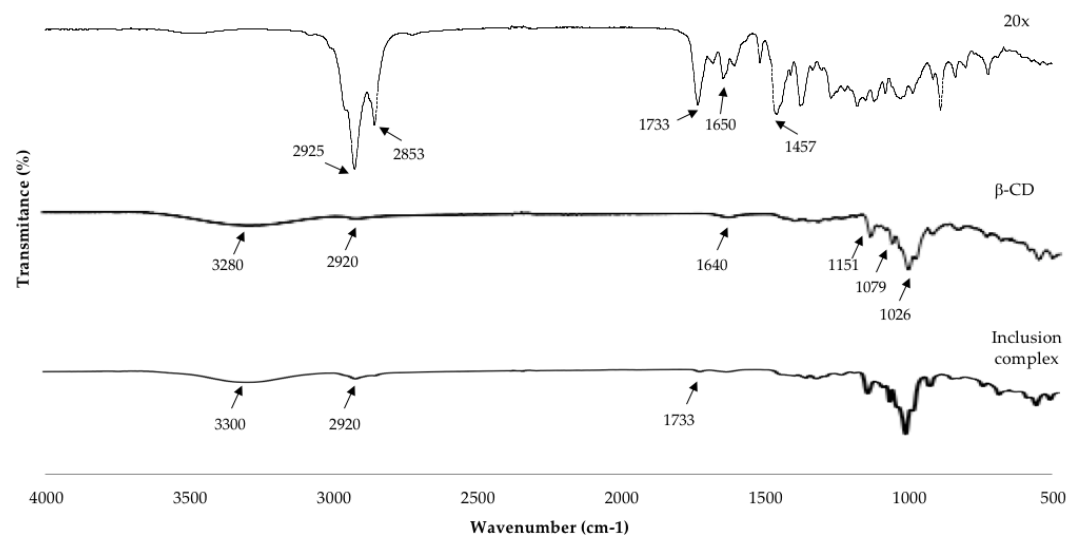
Figure 3. FTIR spectra of 20x, β–CD, inclusion complex (20x-β–CD).